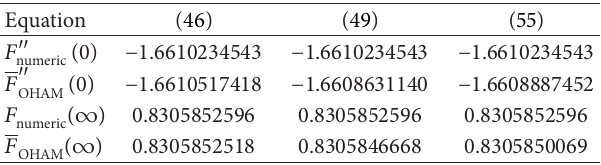
Table 6: Comparison of the first-order approximate solution 𝑓 obtained by OHAM with numerical results.